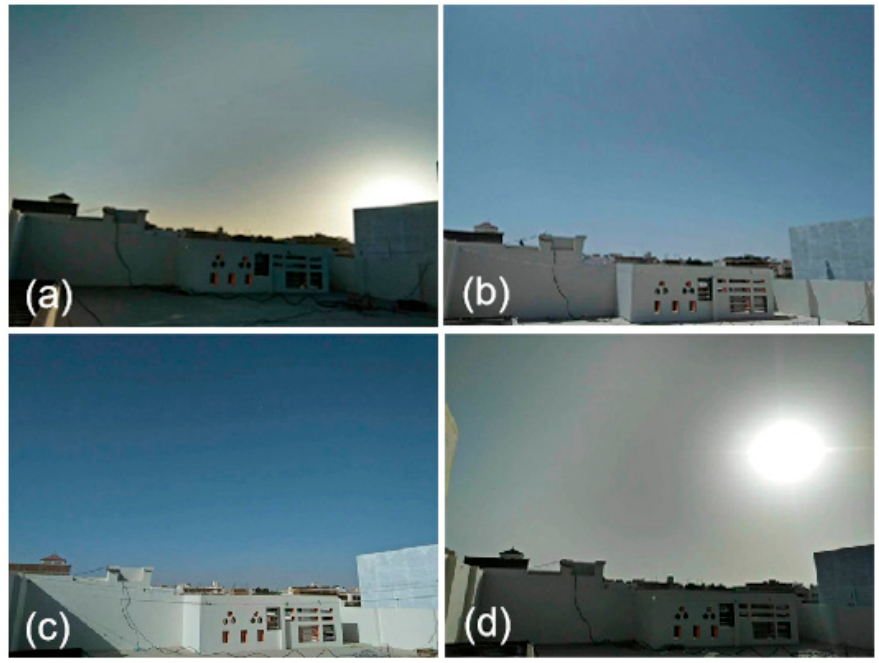
Figure 11. Test samples from testing dataset, ( a – d ) images are unhealthy category. The training for various numbers of epochs results in significant values of the classi- fication rate, as shown in Table 6. These values, which range from 0.5866 to 0.7014, are computed over a training period of 25,934.44 s. Precision in performing the categorization operation is made possible by MiniBatchsize’s low value.